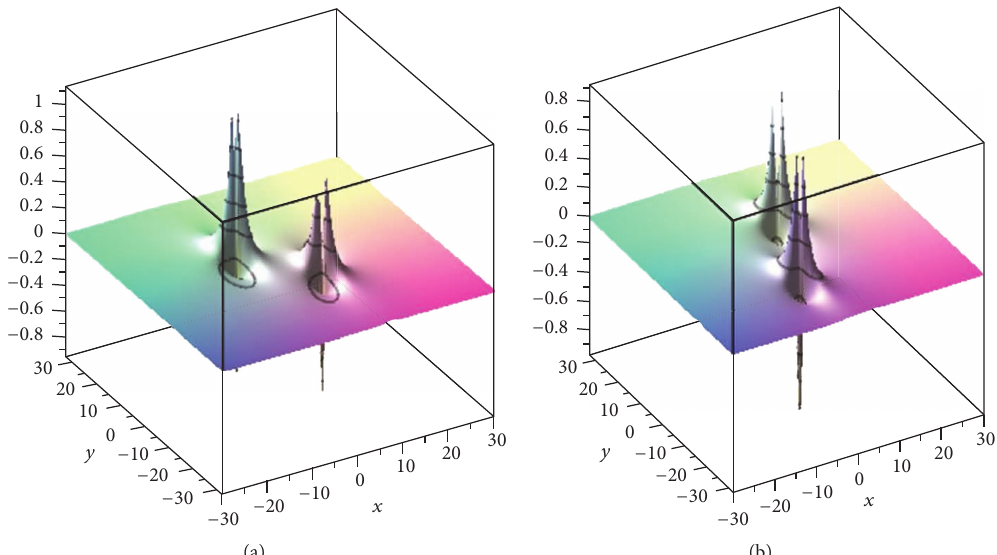
Figure 2: Location and form of the two pulses: incoming ( 𝑡 = −10 ) and outgoing ( 𝑡 = 10 ) corresponding to the election of 𝑎 = 𝑏 = 1 . The scattering process is